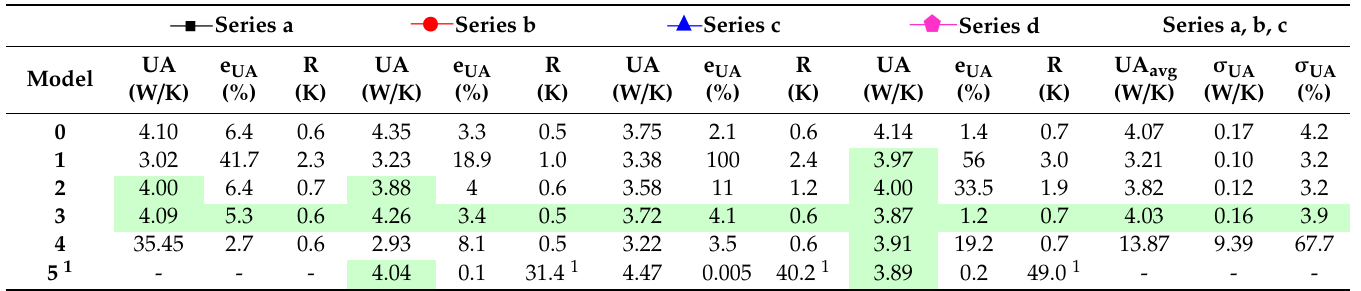
Table 14. Whole building. Models including non-measured variables. Output: T i . Summary of the results. UA values, and average of the residuals.